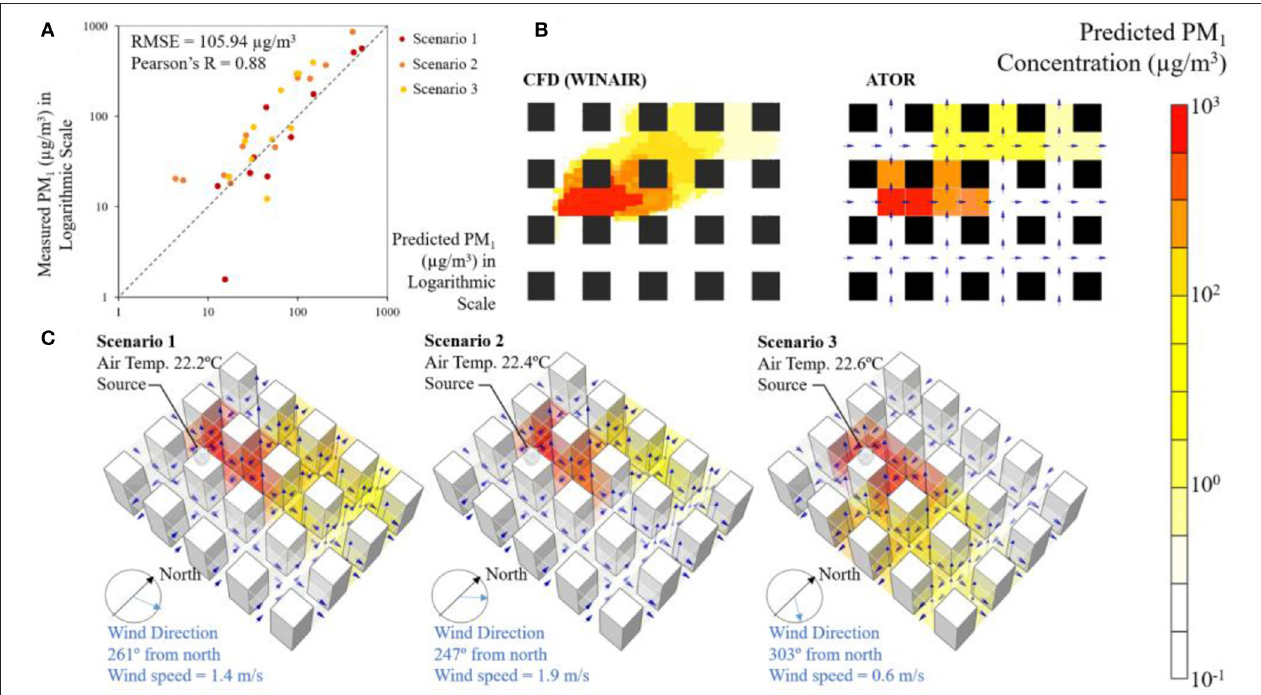
FIGURE 6 | (A) Predicted and measured PM 1 concentration during the smoke tracer experiment; (B) planar view of predicted PM 1 concentration for Scenario 2 at the height of 0.9m above ground by the CFD model (WINAIR) and the ATOR model; and (C) visualization of the predicted PM 1 concentration using the ATOR model under various wind direction and speed during the smoke tracer experiment.